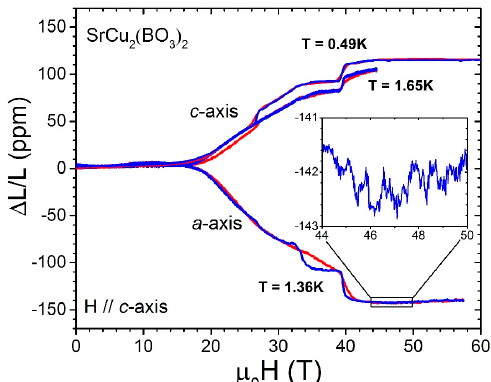
Figure 6. Transverse magnetostriction of SrCu 2 (BO 3 ) 2 measured at cryogenic temperatures below 2 K. The data were taken in a 60 T long-pulse magnet (2.5 s long) at the NHMFL using the method described in Section 2.2. Red curves were taken during magnetic field upsweep, blue curves during downsweep. These curves do not completely overlap due to cooling/heating caused by magnetocaloric effect. Superstructure in both axial and transverse magnetostriction is evident. The strain resolution achieved in these measurements is better than 10 − 6 [15] as shown in the inset.